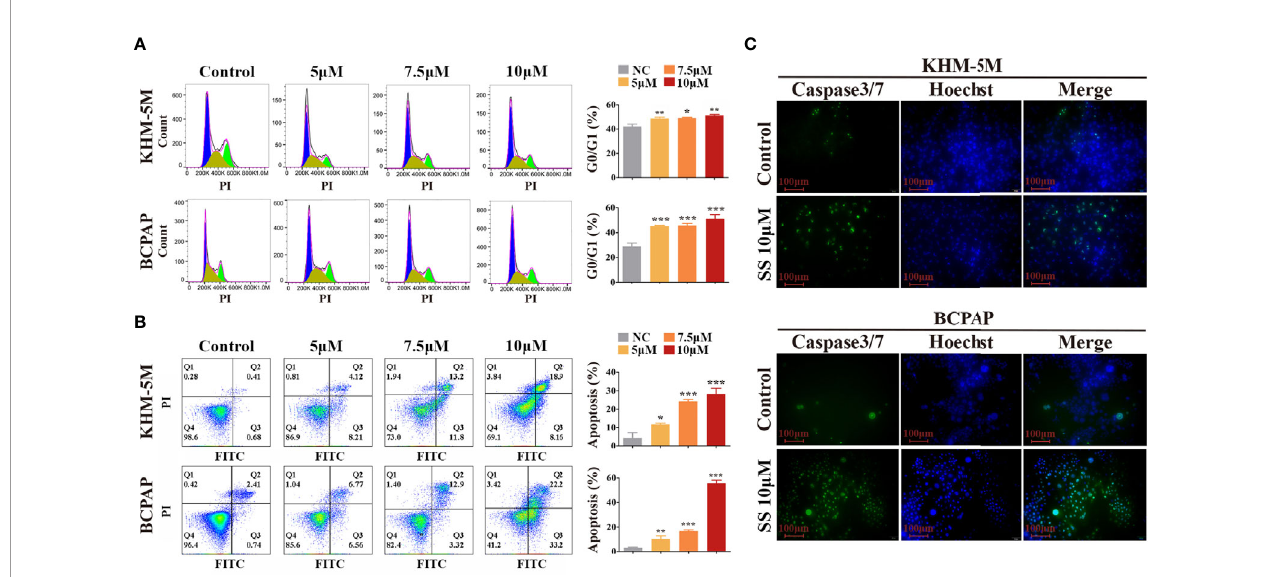
FIGURE 2 | SS induces G0/G1 cell cycle arrest and apoptosis in thyroid cancer cells. (A) Cell cycle analysis was performed in KHM-5M and BCPAP cells after SS incubation for 24 h. (B) Apoptosis was evaluated by fl ow cytometry after treatment with the indicated concentrations of SS for 24 h. (C) Caspase-3/7 activity after SS treatment for 24 h. SS, sodium selenite. *P < 0.05; **P < 0.01; ***P <